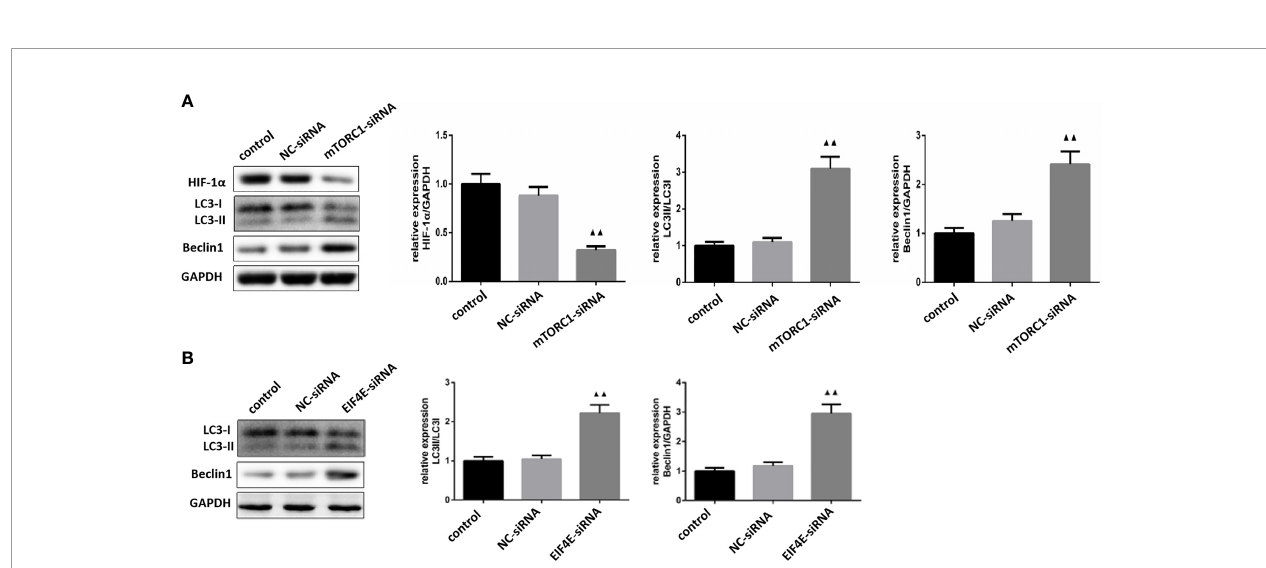
FIGURE 8 | (A) Expression levels of HIF-1 a , LC3 and Beclin1 in glioma cells silenced by mTOR C1( (cid:1) x ± S, n =3). (B) Expression levels of LC3 and Beclin1 proteins in glioma cells silenced by eIF4E ( (cid:1) x ± S, n =3). Compared with the normal control group, ▲▲ P